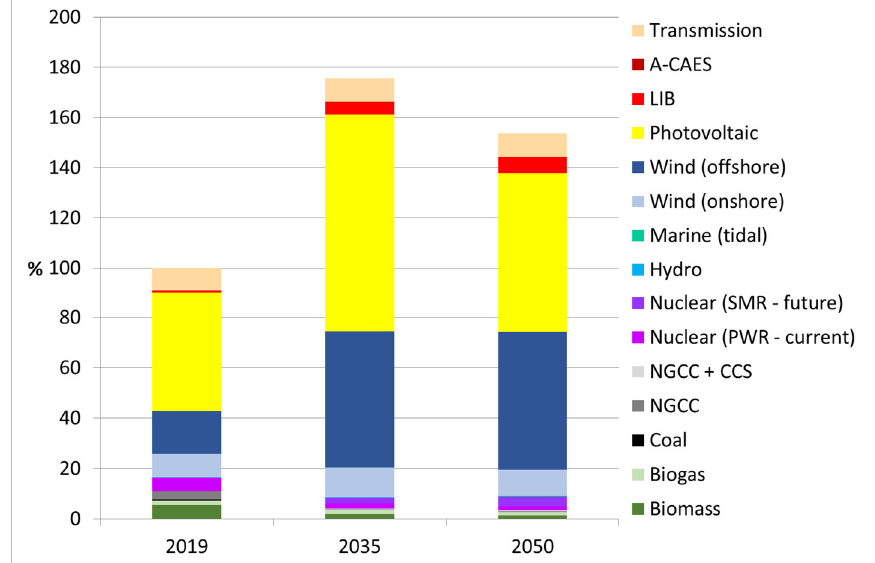
Figure 11. Abiotic depletion potential (elements) per unit of electricity delivered by the UK grid mix (including energy storage and transmission), expressed as relative to the 2019 value (100% = 3.6 · 10 − 4 g Sb-eq/kWh).